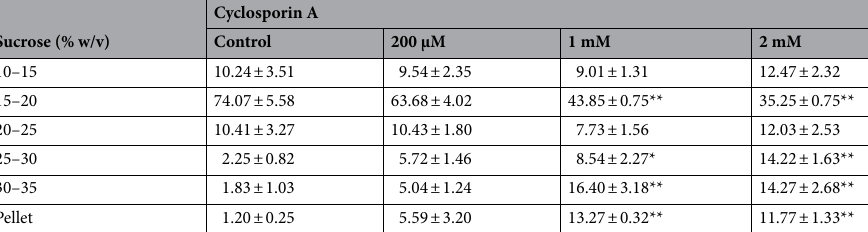
Table 1. Percentage of MUC5B in sucrose gradient fractions (CsA concentration-dependence). Results are presented as the mean ± s.e.m. (n = 3–5) from 3 independent experiments. * P < 0.05, ** P < 0.01 compared with control condition (ANOVA followed by Dunnett’s method). The percentage of MUC5B in fractions across the sucrose gradient was calculated from Figs. 1 and 2.